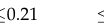
Table 2. Mechanical properties of J55 steel in API Specification 5CT/ISO 11960 [18].